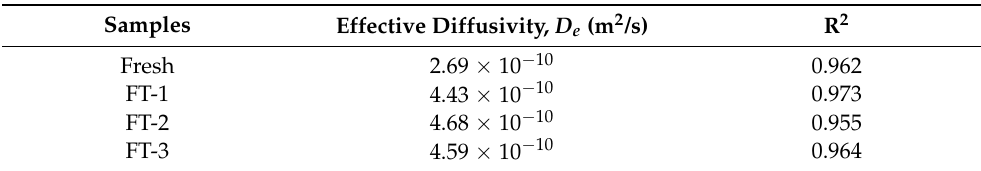
Table 3. The effective moisture diffusivity ( D e , m 2 /s) of raw blueberry and freeze-thaw (FT) treated blueberry fruit at 60 °C. FT-1, FT-2 and FT-3 represent the sample with FT treatment once, twice and third times.